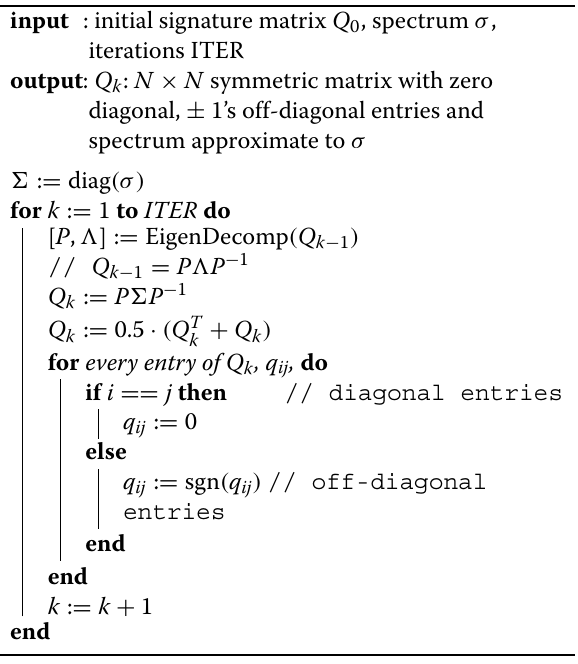
Algorithm 1: Signature matrix construction